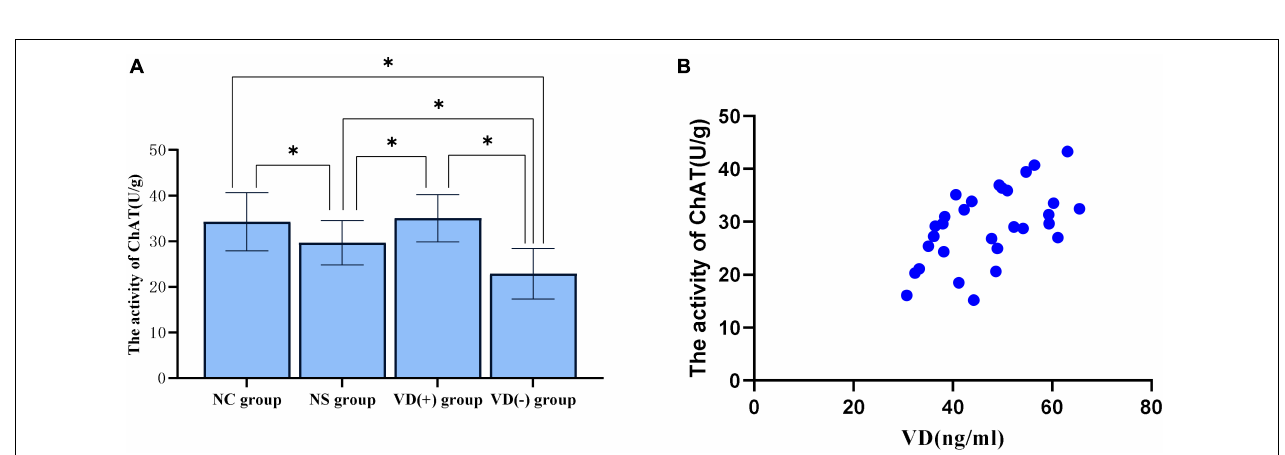
FIGURE 5 | Comparison of ChAT activity in hippocampal region between groups and correlation analysis between VD level and ChAT activity. (A) Comparison of the vitality of ChAT between the groups, ∗ P < 0.05. (B) Scatter plot of correlation analysis between VD and ChAT activity.